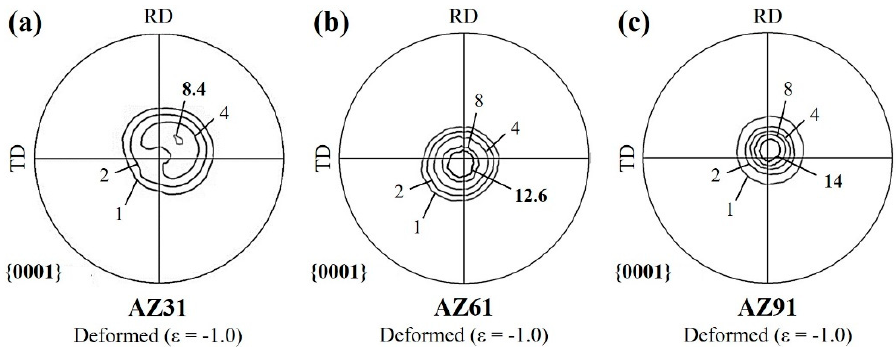
Figure 6. (0001) pole fi gures of ( a ) AZ31, ( b ) AZ61, and ( c ) AZ91 alloys deformed at a temperature of 723 K under a fi nal strain rate of 5.0 × 10 − 2 s − 1 up to a strain of − 1.0.